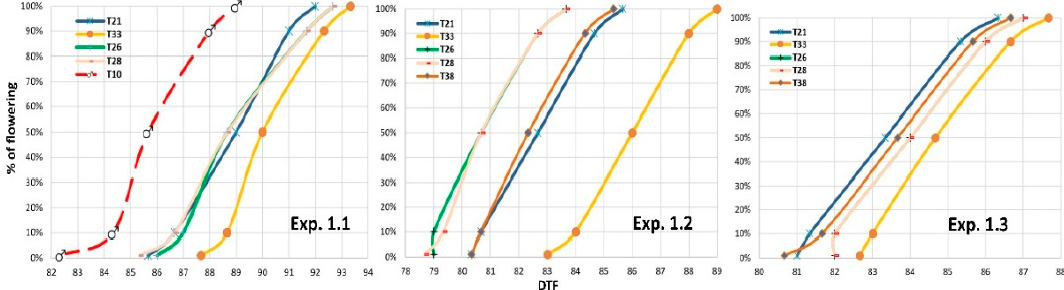
Figure 2. Days to flowering (DTF) of lines T21, T26, T28, T33 and T38 (females) and T10 (male) in Exps. 1.1, 1.2 and 1.3.